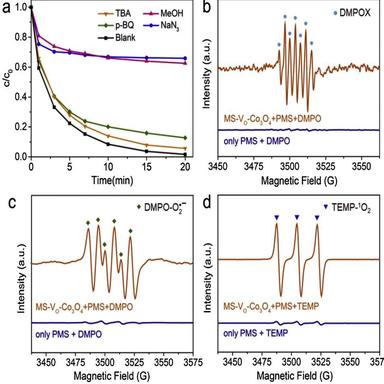
(a) Effects of radical scavengers on 4-CP degradation catalyzed by the MS-VO-Co3O4. EPR spectra with the addition of (b) DMPO (deionized water as the solvent), (c) DMPO (MeOH as the solvent), and (d) TEMP. Reaction conditions: = 50 mg/L, = 200 mg/L, catalyst = 50 mg/L, = 200 mM, = 200 mM, = 1 mM, = 1 mM, = 150 mM, = 150 mM.